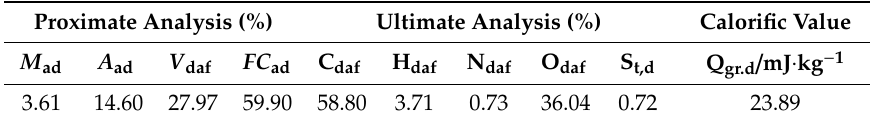
Table 1. Characteristic parameters of coal quality.